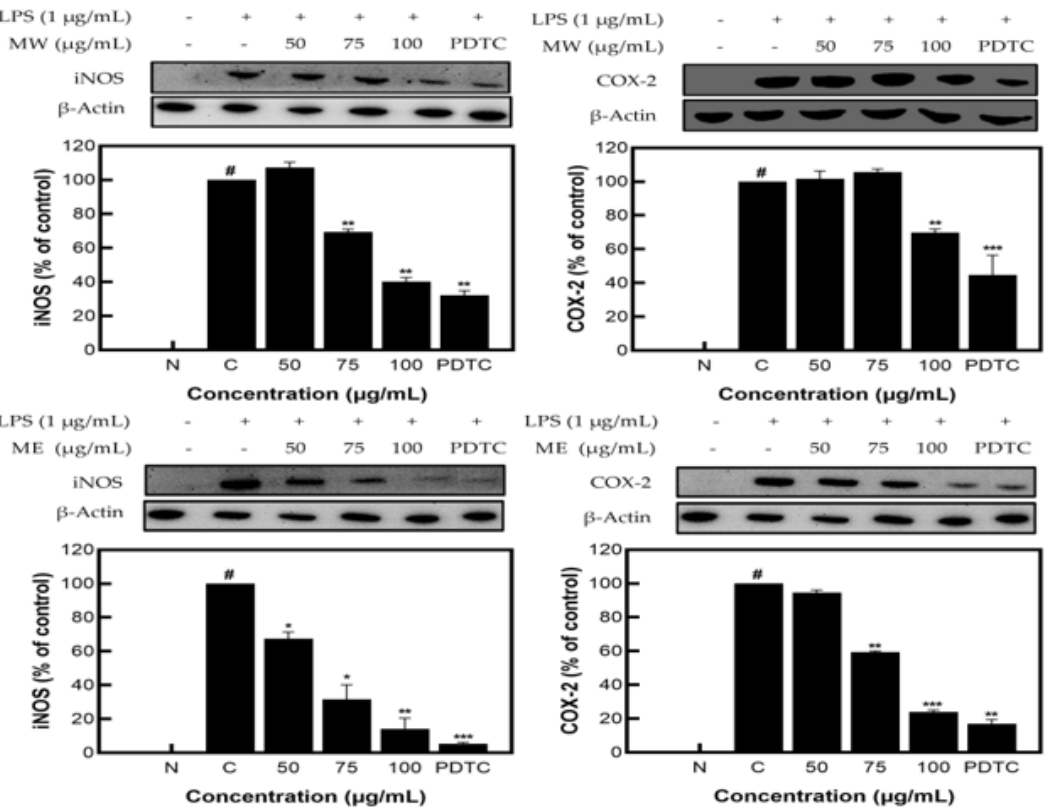
Figure 3. iNOS and COX − 2 protein expression rate of M. pruriens extracts on macrophage cell (RAW 264.7). MW: M. pruriens extracted with hot water; ME: M. pruriens extracted with 70% ethanol; PDTC: ammonium pyrrolidine dithiocarbonate. N: normal, not treated with LPS; C: control,